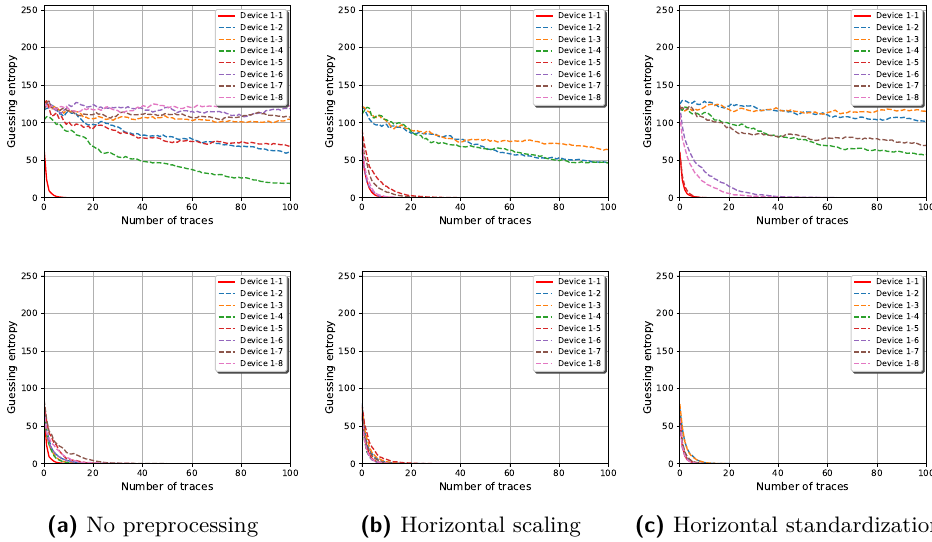
Figure 9: Influence of preprocessing on (top) pre-trained models and (bottom) fine-tuned